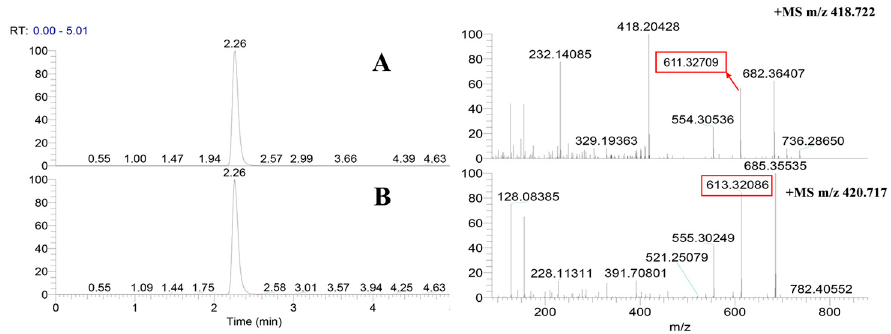
Figure 6. The MS/MS extracted ion chromatograms and the MS/MS spectrum of the reference peptide G-R ( A ) and the internal reference peptide iso/G-R ( B ).